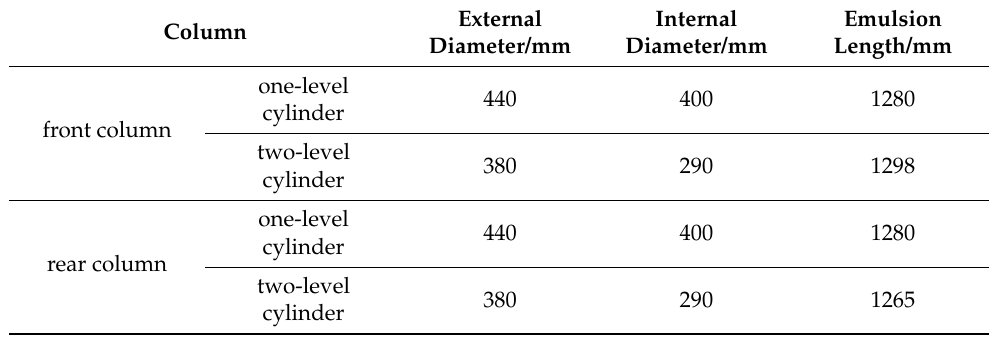
Table 2. Dimension parameters of column structure.